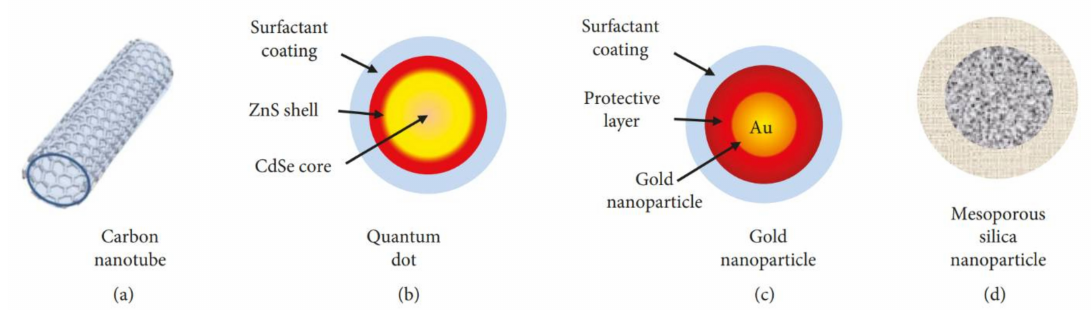
Figure 7. Example of the most employed inorganic nanocarriers: ( a ) carbon nanotubes, ( b ) quantum dots, ( c ) gold nanoparticles, and ( d ) mesoporous silica nanoparticles